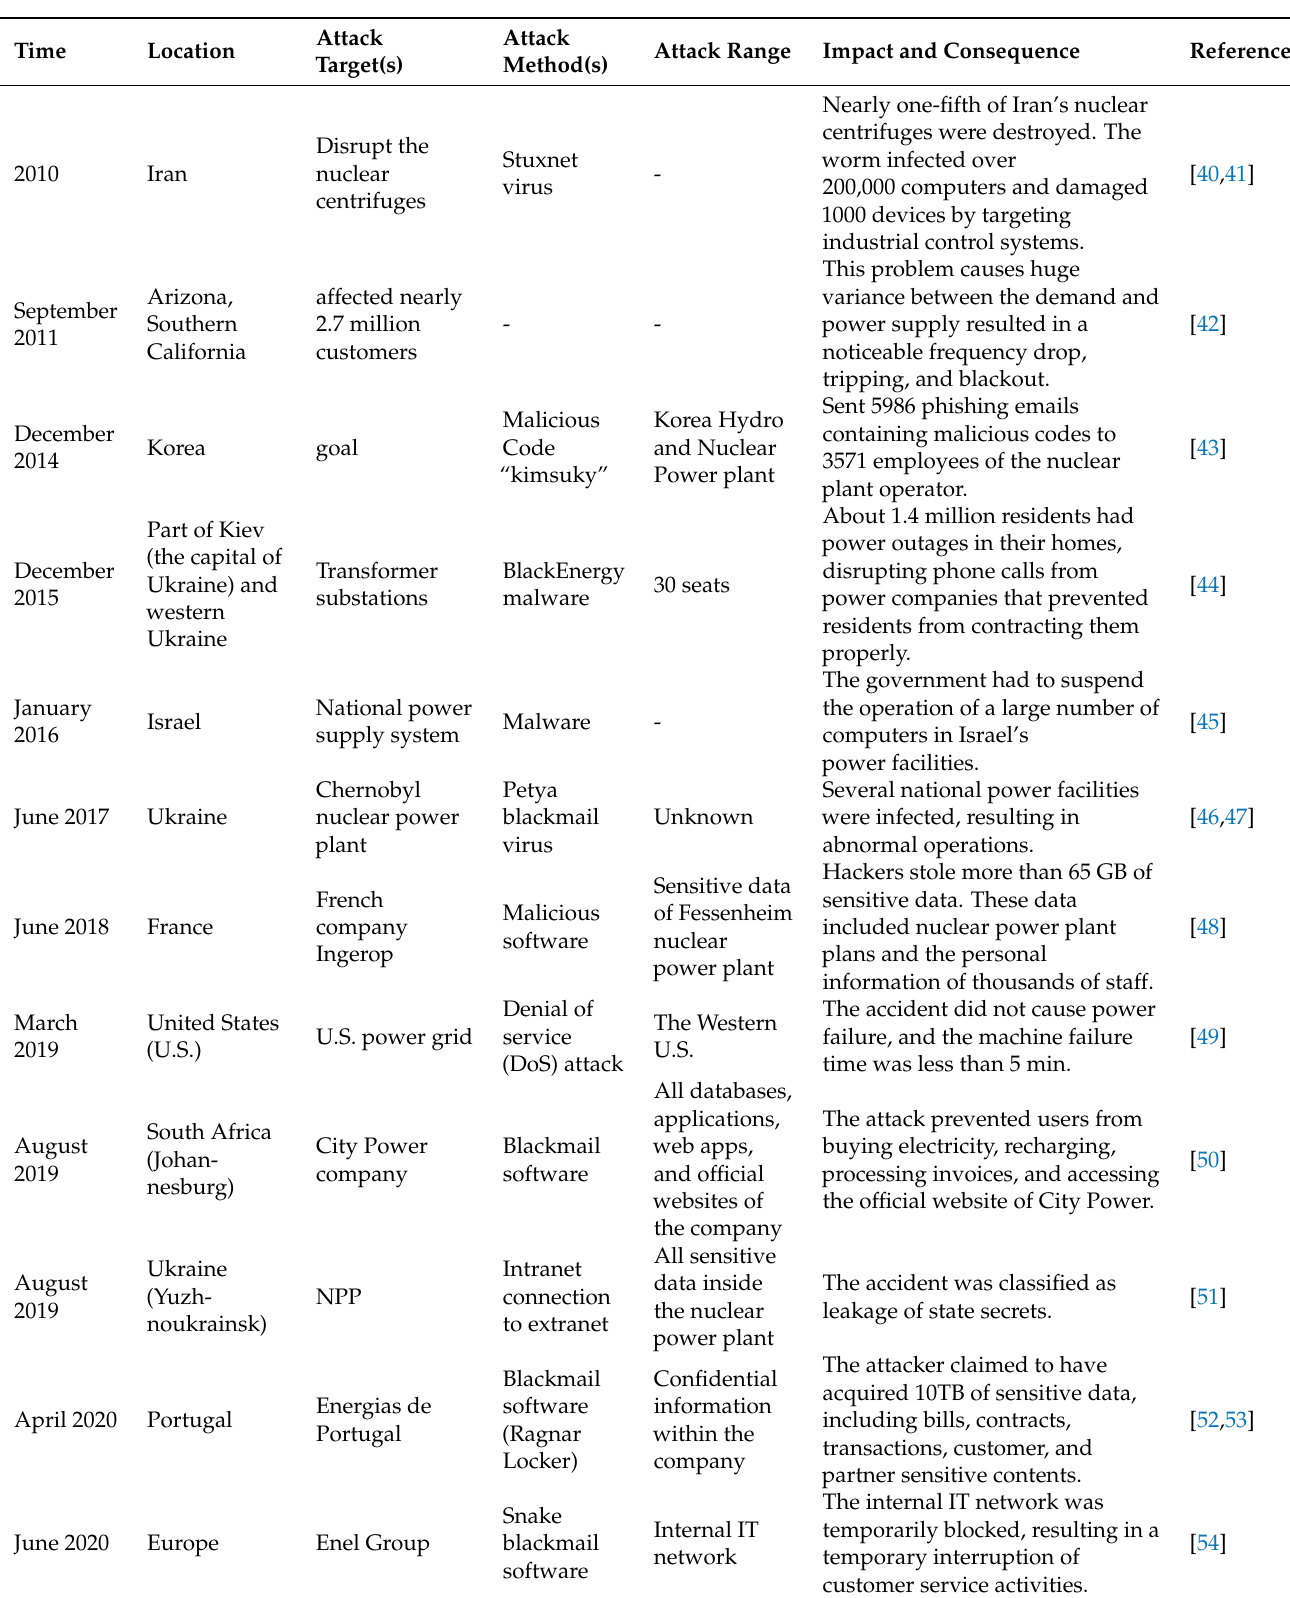
Table 2. Globally serious smart grid attacks and